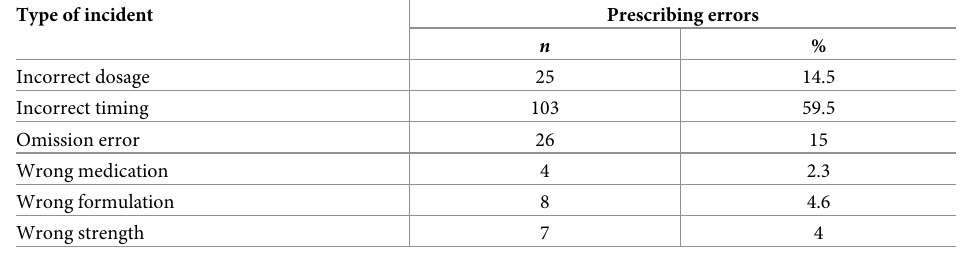
Table 2. Types of Parkinson’s medication errors that occurred when prescribing on first medication chart follow- ing admission for people with Parkinson’s disease.